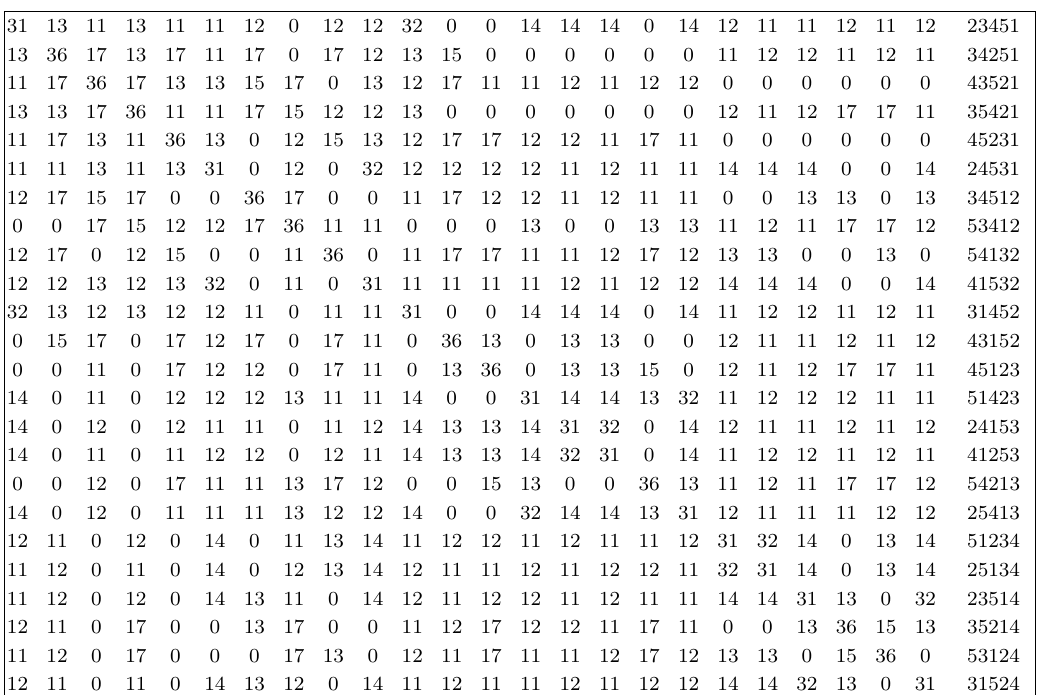
Table 4 . Representation of the TMD-valued color matrix and vector of partial amplitudes for the processes g (cid:3) g 2 ! g 3 g 4 g 5 . Each pair ij of intergers represents N i 1 the entry vanishes. The last column gives the permutation associated with the partial